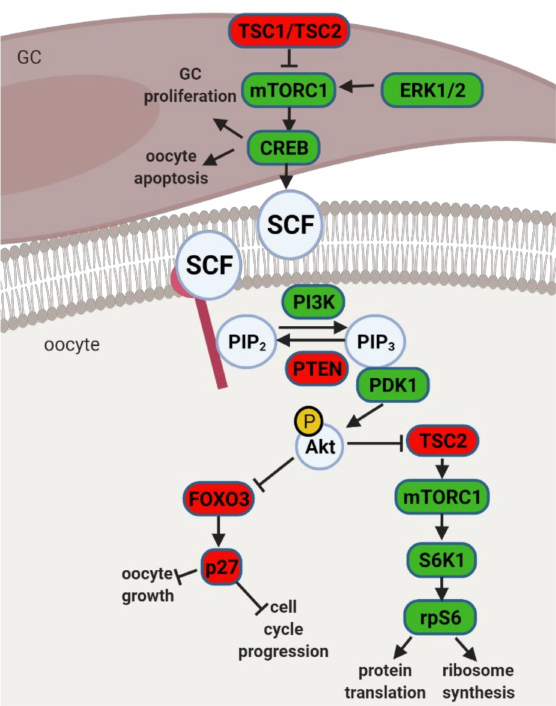
Figure 4. Schematic representation of mammalian target of rapamycin (mTOR) and phosphatidyli- nositol 3 kinase (PI3K) signaling pathway and its downstream regulators in the granulosa cells (GC) and oocyte. Extracellular signal-regulated protein kinase 1 (ERK1/2) activates mTOR complex 2 1 (mTORC1) in pre-GC to initiate the activation of primordial follicles. mTORC1 activates cyclic AMP-response element binding protein (CREB), which promotes stem cell factor (SCF) transcription and stimulates PI3K signaling but also affects pre-GC proliferation and oocyte apoptosis. mTOR signaling negative regulators TSC1 and TSC2 suppress mTORC1 activity. PI3K signaling pathway is activated by SCF in the oocyte. PI3K phosphorylates phosphatidylinositol-4,5-biphosphate (PIP 2 ) to phosphatidylinositol-3,4,5-triphosphate (PIP 3 ), which interacts with 3-phosphoinositide dependent protein kinase 1 (PDK1) for subsequent phosphorylation of protein kinase B (Akt) and forkhead box O3 (FOXO3) with its downstream mediator, cyclin-dependent kinase inhibitor 1B (p27). Upon phosphorylation, the inhibitory effect of FOXO3 and p27 on cell cycle progression and oocyte growth is inhibited, and the primordial follicle is recruited. Akt also activates ribosomal protein S6 kinase beta-1 (S6K1) through inhibition of TSC2 with subsequent mTORC1 activation and further ribosomal protein S6 (rpS6) phosphorylation, which leads to protein translation and ribosome synthesis. Factors indicated in red are associated with follicle dormancy; molecules indicated in green are associated with follicle activation. Created with BioRender.com, accessed on 1 November